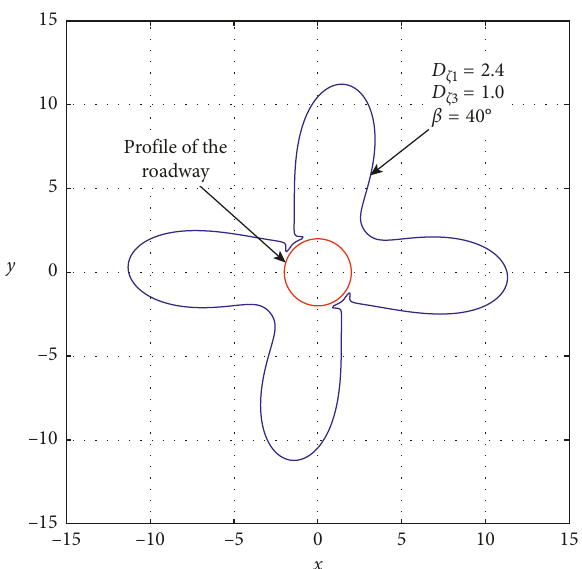
Figure 16: Distribution of the plastic zone in surrounding